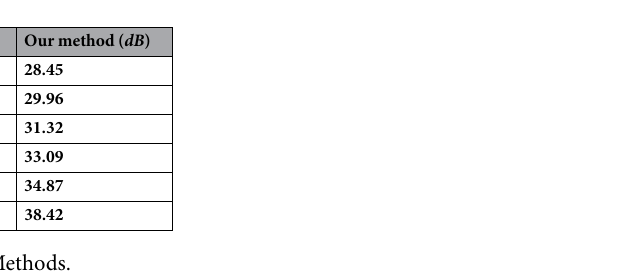
Table 1. PSNRs of Three Different